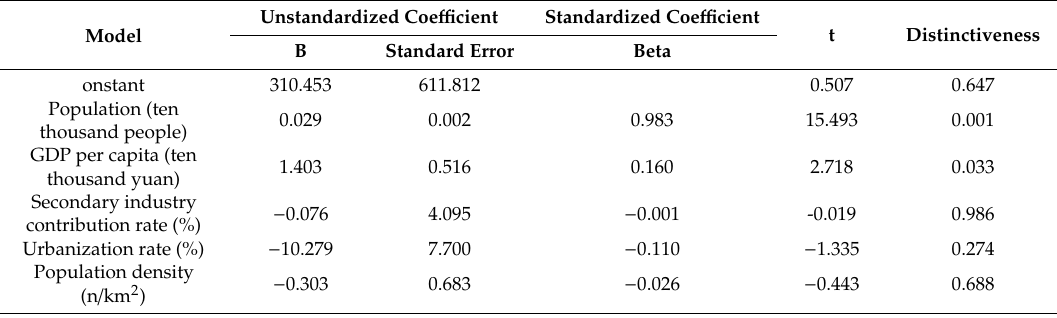
Table 9. The regression equation independent variable coe ffi